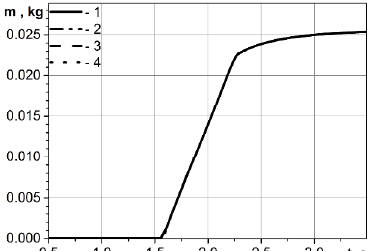
Fig. 4. The mass of the melt. The results of simulation for a different value of the gas flow velocity. 1 – 10 m/s, 2 – 50 m/s, 3 – 100 m/s, 4 – 150 m/s. The mass quantity that left the central part of the fuel rod for different contact angle and for gas velocity that equal 100 m/s is presented in figure 5. As we can see the contact angle influence is negligible.